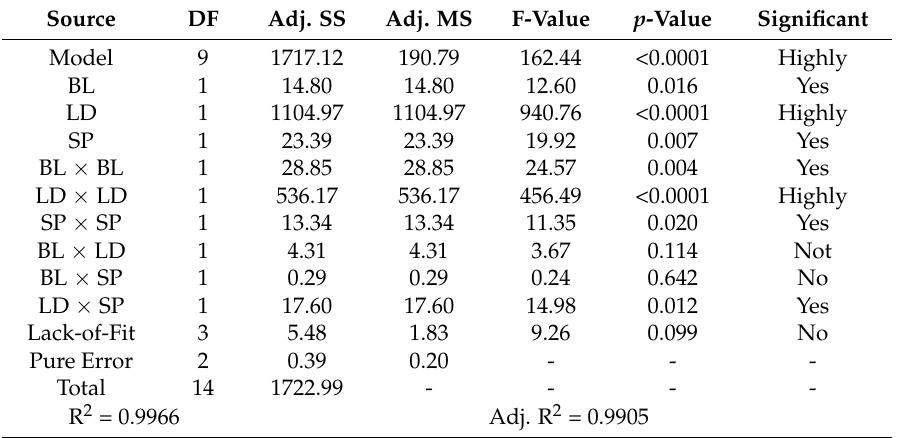
Table 11. ANOVA results of the interactive effect of biodiesel blends, load, and speed on brake thermal efficiency (BTE).